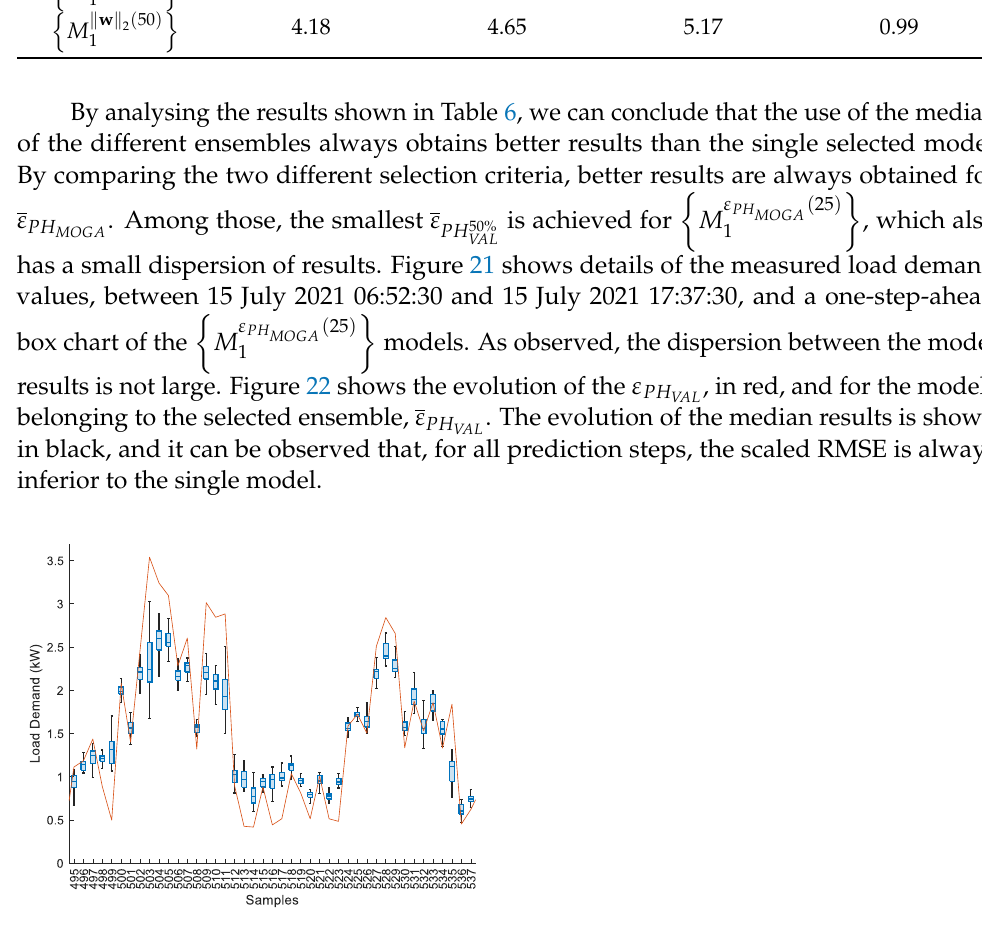
Figure 21. Load Demand detail. Measured values (red) and one-step-ahead box plot of (cid:27) (cid:26) (25) ε PHMOGA M (blue). 1